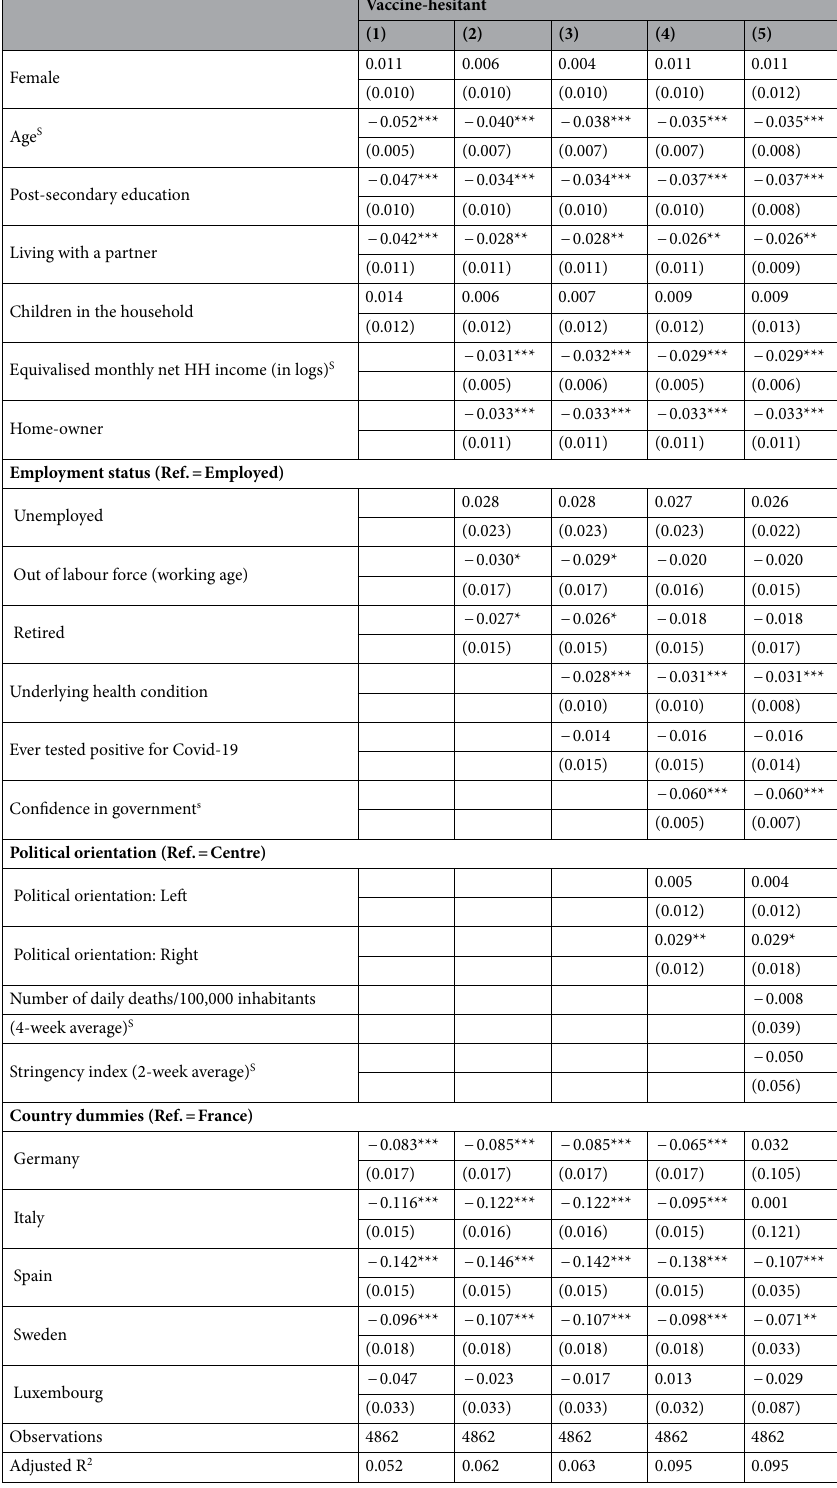
Table 2. The predictors of vaccine hesitancy—ordinary least squares results. All regressions include day-of- interview fixed effects. All continuous independent variables are standardised: these are indicated by a S next to the variable name. Standard errors in column (5) are clustered at the country*day of the interview level. *, **, and *** indicate respectively significance at the 10%, 5% and 1%